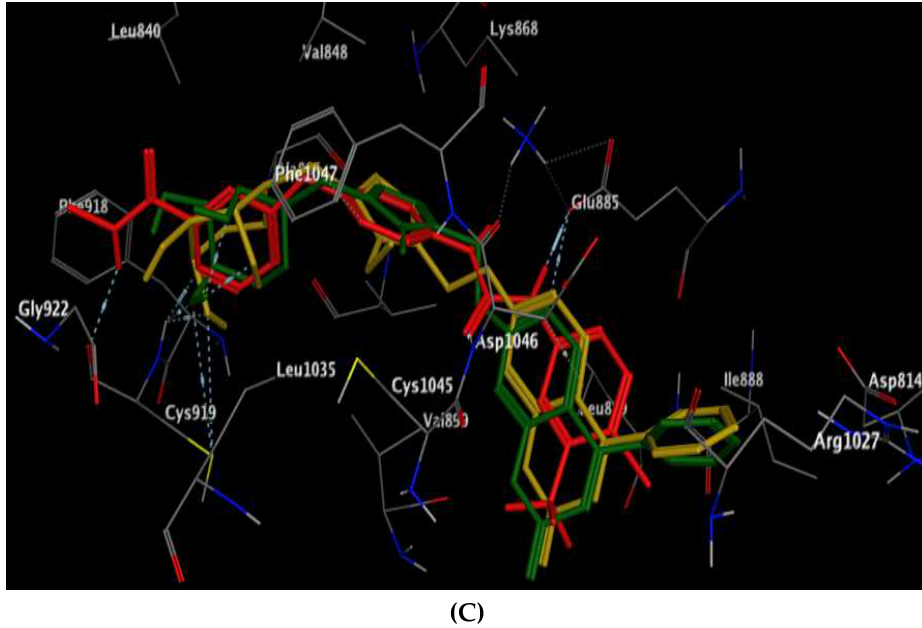
Figure 7. ( A–B ) views illustrate the 2D binding features of the coumarin targets, 8 and 10 , while ( C ) view illustrates the 3D superimposition between the original ligand sorafenib (red), 8 (green) and 10 (yellow) within the active site of VEGFR-2 (PDB code: 4ASD), respectively.